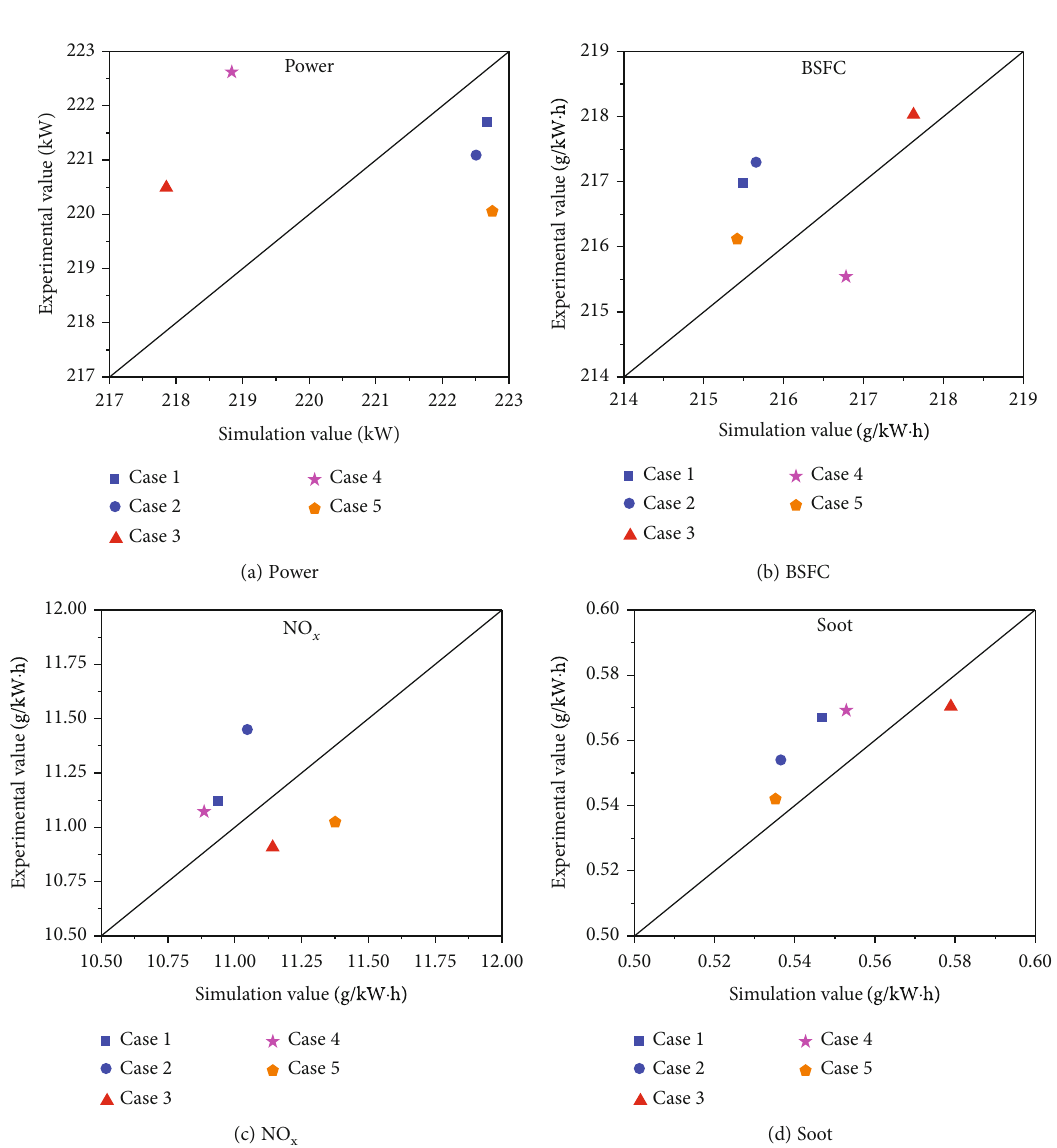
Figure 11: Comparison of the simulation results with constant fuel injection